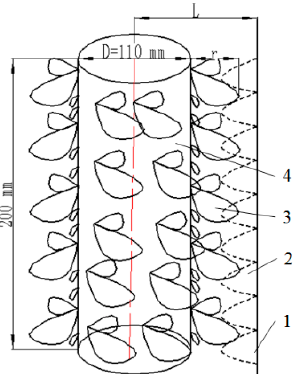
Figure 4. The distance between the harvesting knife and the bacterial stick. (1) Knife holder; (2) Harvesting knife; (3) Auricularia auricula; and (4) Fungus stick. Note: L is the distance from the center of the fungus stick to the harvesting knife seat, mm; D is the direct fungal stick, mm, and the direct fungal stick is 110 mm in this test; r is the length of the ear piece, mm; and the length of spring ear when harvested is from 15 mm to 35 mm.